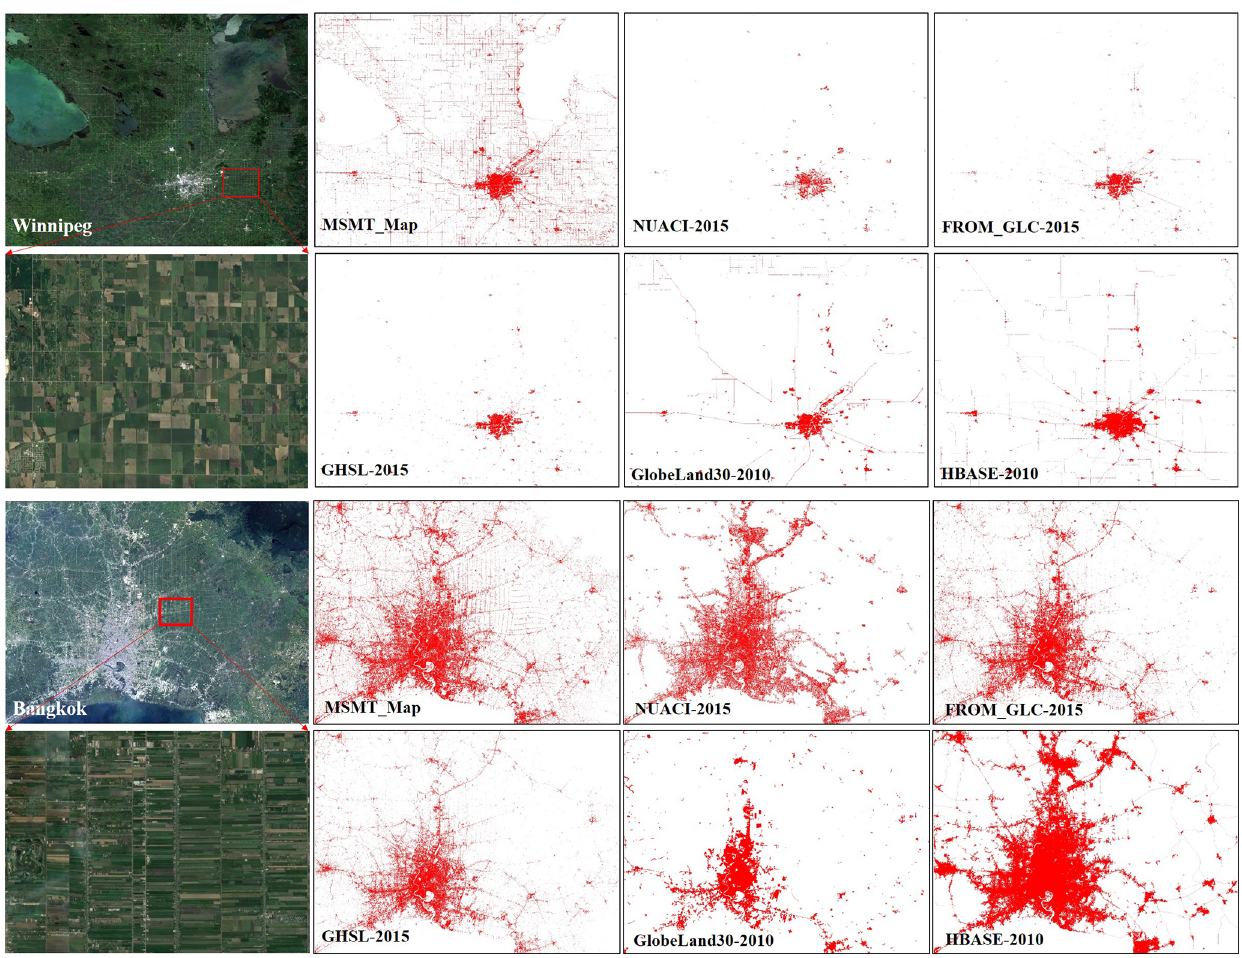
Figure 9. Comparisons between the MSMT_RF-based impervious surface maps and other products (corresponding to the NUACI products developed by Liu et al., 2018; the FROM-GLC products developed by Gong et al., 2013; the GHSL products developed by Florczyk et al., 2019; the GlobeLand30 products developed by Chen et al., 2015; and the HBASE products developed by Wang et al., 2017a, respectively) for five regions with various impervious landscape. The Landsat imagery and corresponding local enlargements came from the United States Geological Survey (https://earthexplorer.usgs.gov/, last access: 8 July